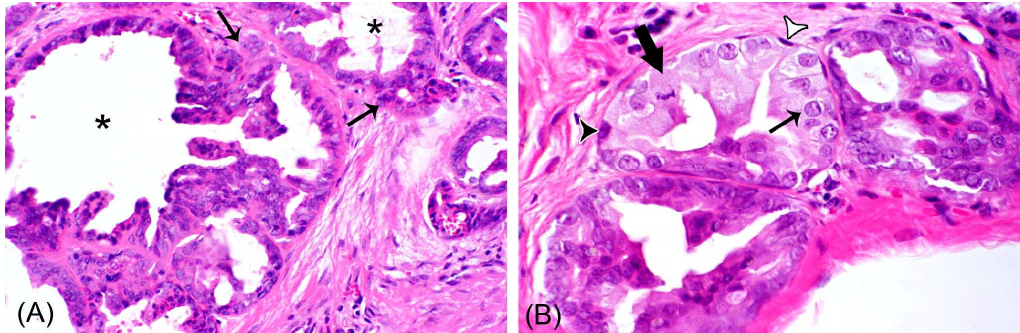
Figure 2. Using histology, all rabbit mammary adenocarcinomas show areas with non-neoplastic myoepithelial cells (ME cells) and areas of invasive carcinoma: ( A ) Depicted is an area composed of neoplastic cells arranged in tubular and cystic structures (asterisks) with multifocal infiltration of the stroma (thin arrows). Hematoxylin–eosin (HE)-stained ( B ) tubular structures are lined by tumor cells (thin arrow) and are surrounded by ME cells. These are spindle-shaped (white arrowhead) or cuboidal to polygonal (black arrowhead). The thick arrow labels a tumor cell with a mitotic figure.